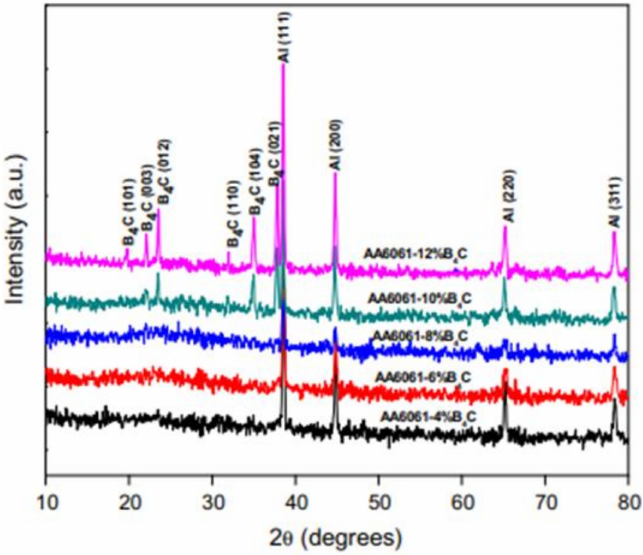
Figure 8. XRD patterns of AA6061–B 4 C composites